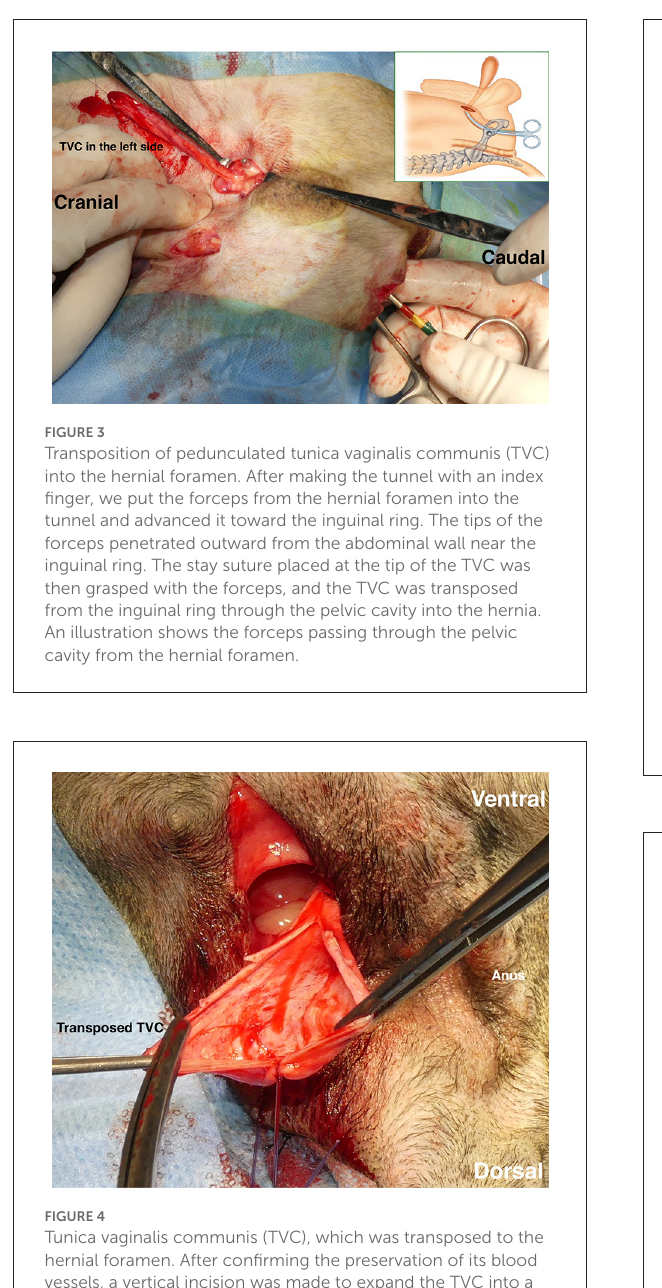
(cid:13) ; Johnson & Johnson). The subcutaneous tissues and (PDS II R skin incisions of the abdominal and inguinal areas were then routinely